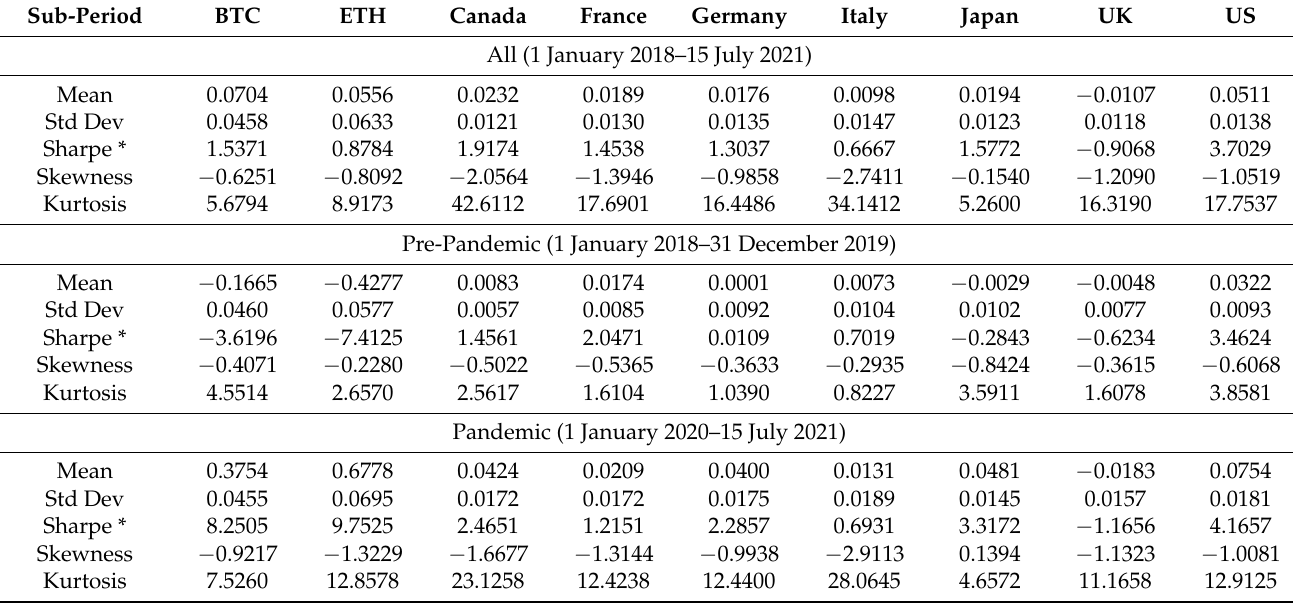
Table 1. Summary Statistics of Cryptocurrency and Stock Daily Returns.